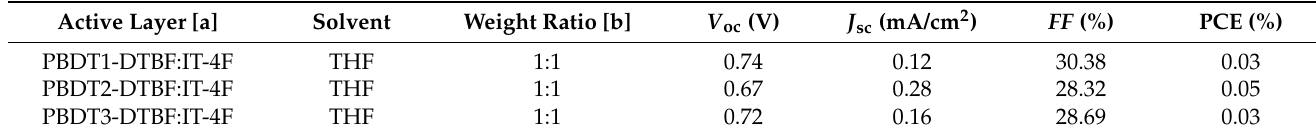
Figure 4. ( a ) Energy level matching diagram of polymer PBDT1-DTBF, PBDT2-DTBF and PBDT3- DTBF and acceptor IT-4F; ( b ) device structure. Table 5. OSC photovoltaic properties of PBDT-DTBF class polymers based on